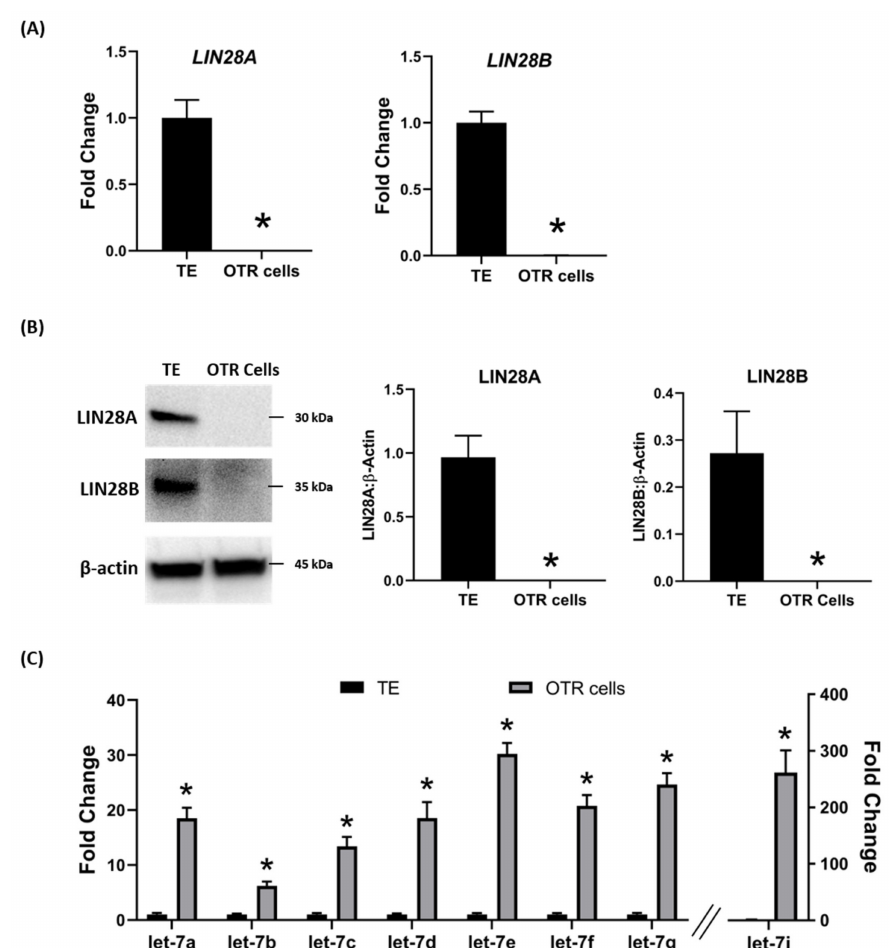
Figure 5. LIN28A, LIN28B, and let-7 miRNAs in non-immortalized ovine trophoblast (OTR) cells. ( A ) LIN28A and LIN28B mRNA in OTR cells compared to day 16 sheep TE. ( B ) Representative immunoblots for LIN28A, LIN28B, and β -actin, and densitometric analysis of immunoblotting results in OTR cells compared to day 16 TE. ( C ) Let-7 miRNAs in OTR cells compared to day 16 TE ( n = 3), * p < 0.05 vs. TE. The e ff ect of low LIN28 and high let-7 miRNAs on proliferation-associated genes in OTR cells was determined by measuring IGF2BP1, IGF2BP2, IGF2BP3, HMGA1, ARID3B, and c-MYC mRNAs and proteins. Real-time PCR showed that mRNA levels of IGF2BP1, IGF2BP2, IGF2BP3, HMGA1, ARID3B, and c-MYC were significantly reduced in OTR cells compared to day 16 TE (Figure 6). Densitometric IGF2BP3, HMGA1, ARID3B, and c-MYC in OTR cells compared to day 16 TE (Figure 7). These results genes in OTR